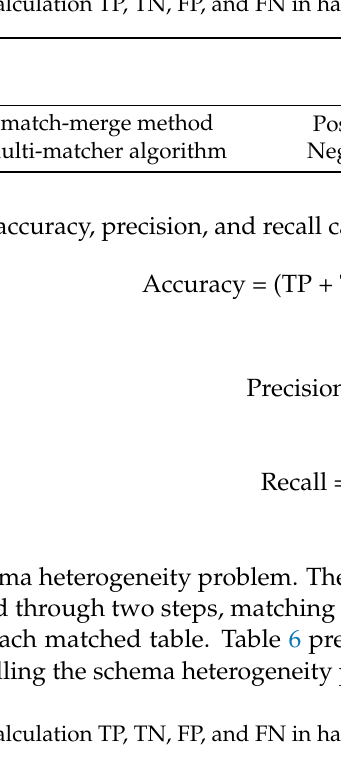
Manual Checking True False Positive TP = 186 FP = 6